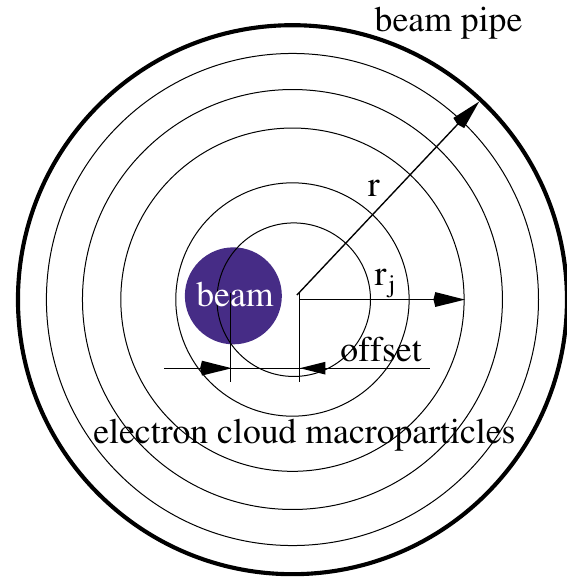
FIG. 3. (Color) Geometry used in the electron cloud simulations.